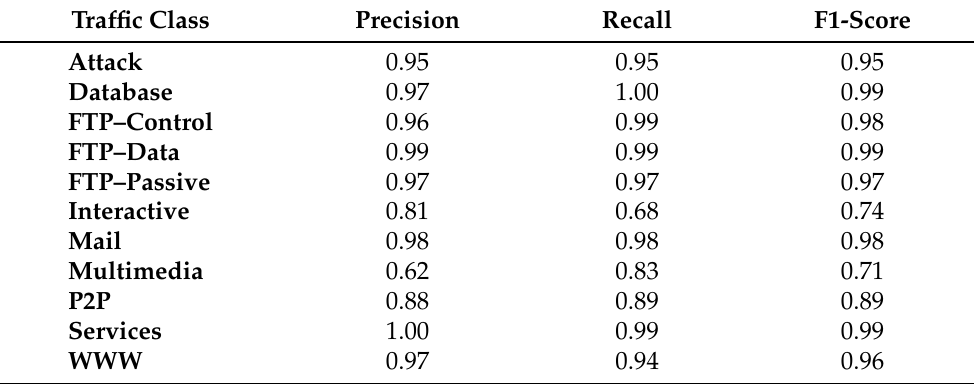
Table 5. Precision, recall, and F1-score per class for KNN